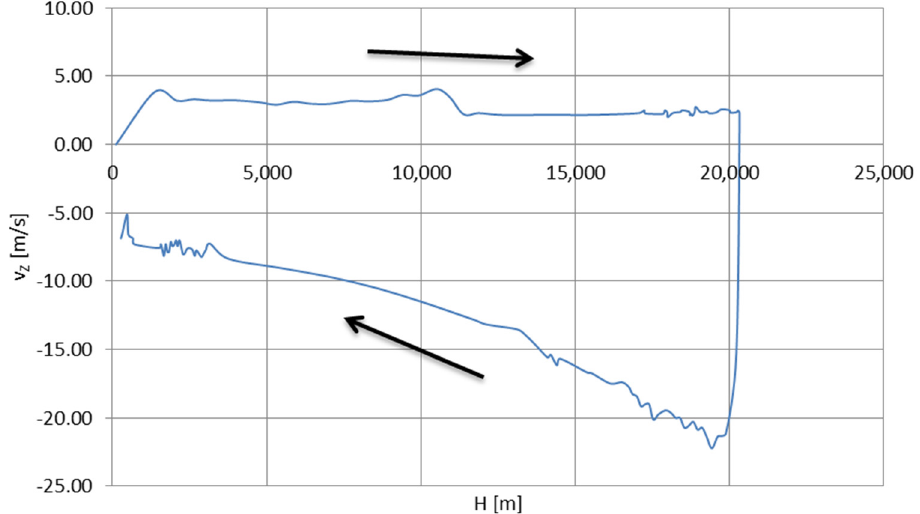
Figure 22. The vertical velocity of the balloon mission plotted against the altitude; the arrows indicate the direction of velocity change with the altitude values (the velocity dropped rapidly at the maximum altitude—the effect of balloon burst and the beginning of the re-entry phase).